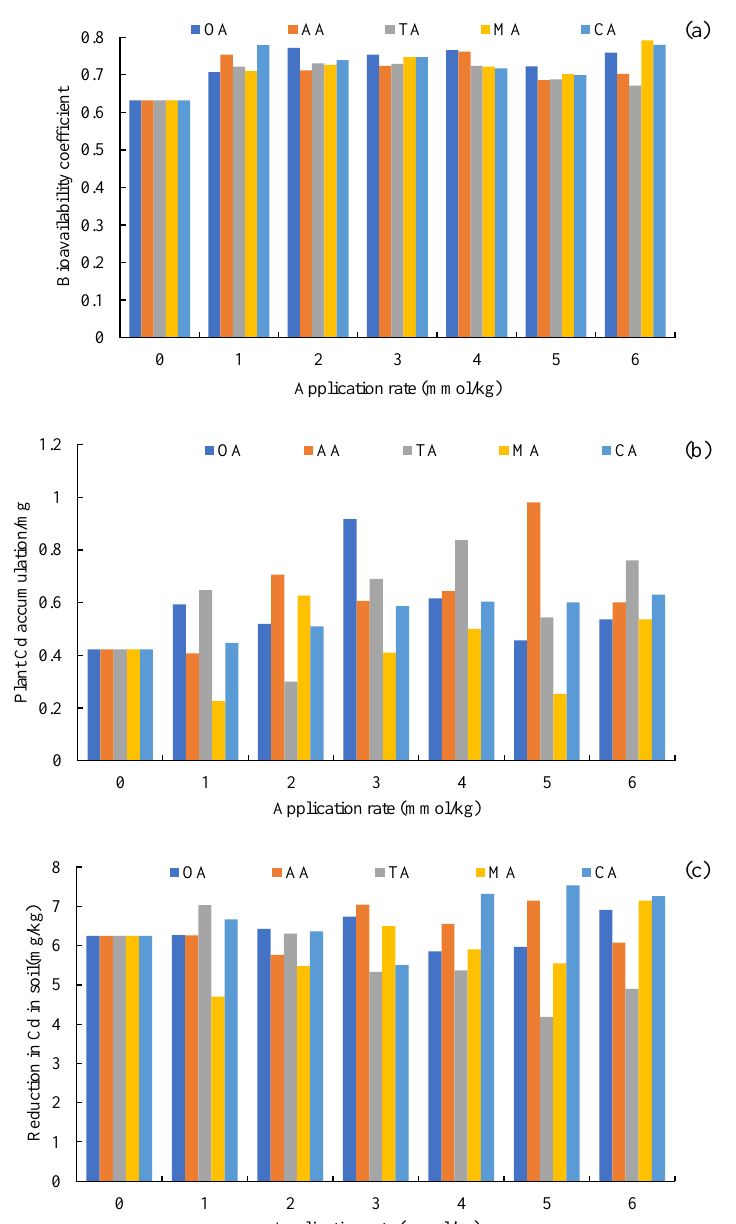
Figure 5. Principal co-ordinates analysis (PCoA) on the soil Cd forms of the organic treatments and the CK (0 mmol/kg); ( a ) oxalic acid (OA), ( b ) acetic acid (AA), ( c ) tartaric acid (TA), ( d ) malic acid (MA), and ( e ) citric acid (CA). A1, A2, and A3 are the three samples of CK (0 mmol/kg); B1, B2, and B3 are the three samples of 1 mmol/kg; C1, C2, and C3 are the three samples of 2 mmol/kg; D1, D2, and D3 are the three samples of 3 mmol/kg; E1, E2, and E3 are the three samples of 4 mmol/kg; F1, F2, and F3 are the three samples of 5 mmol/kg; G1, G2, and G3 are the three samples of 6 mmol/kg.